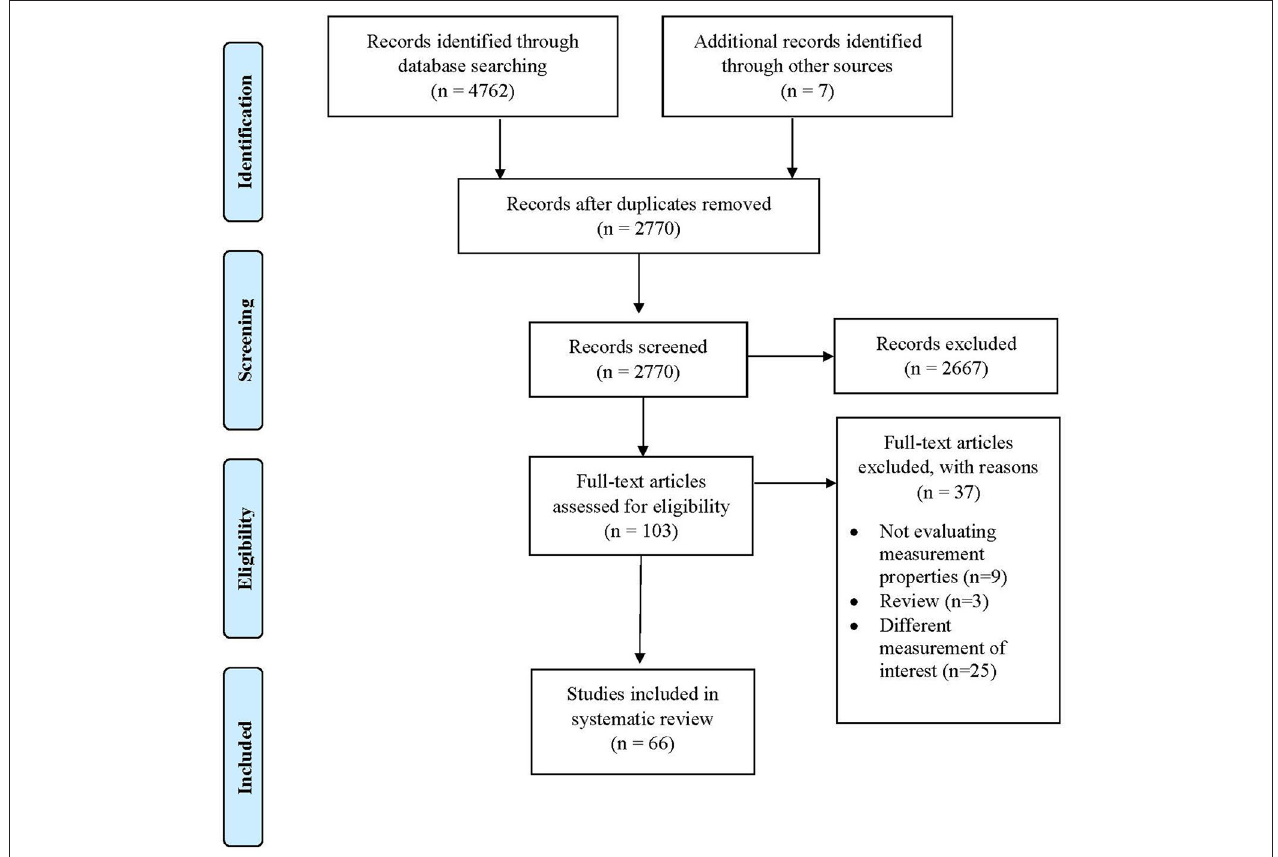
FIGURE 1 | Prisma flow diagram.